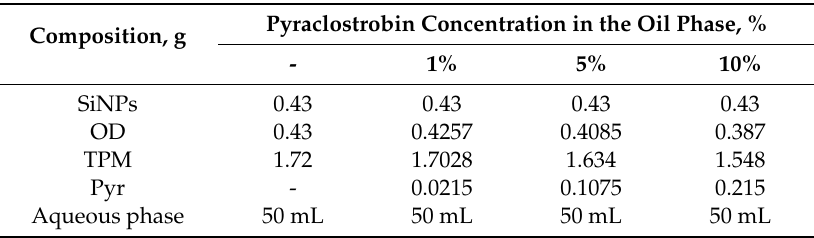
Table 1. The composition of emulsion depending on pyraclostrobin content (OD:TPM ratio is 1:4), g. Composition,